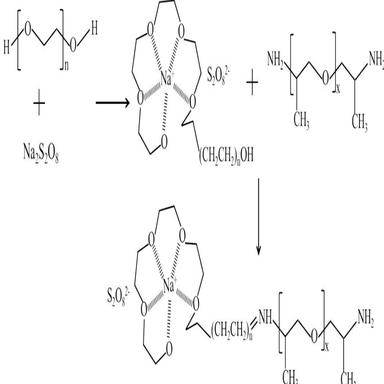
(a) TGA curves for CO2-responsive phase transfer materials (PEG-200, 400, 600); (b) FT-IR spectrum of CO2-responsive phase transfer materials (PEG-200).